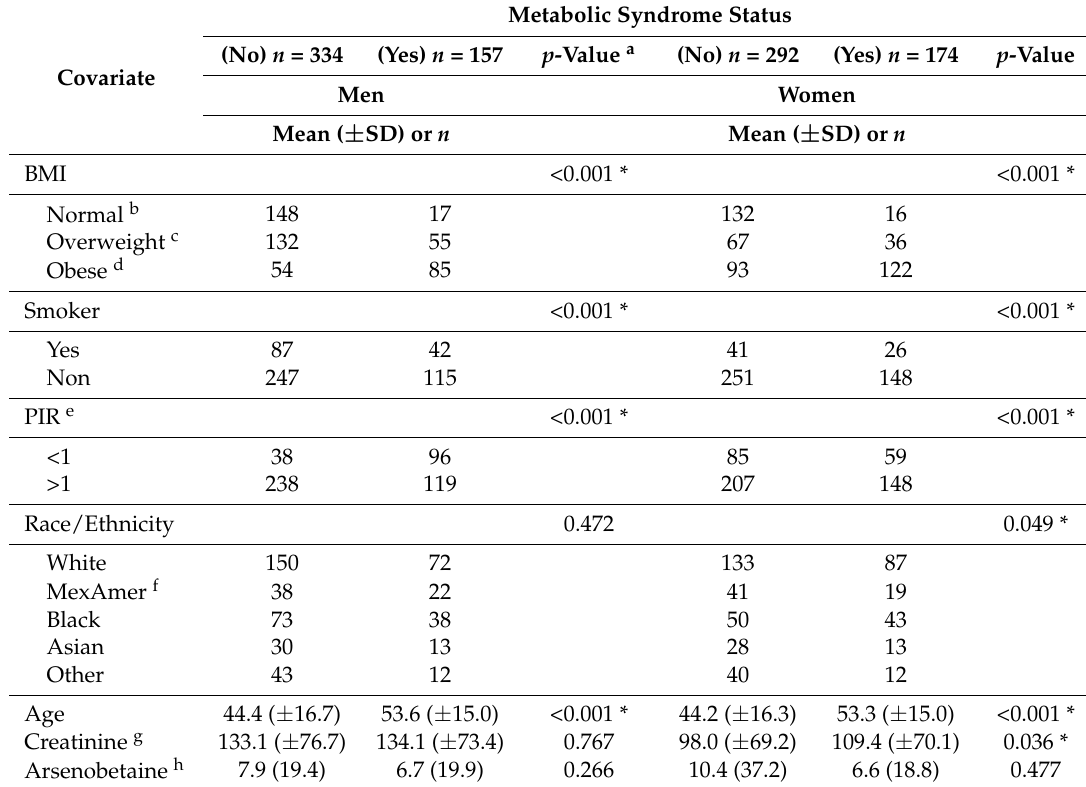
Table 3. Association between metabolic syndrome and